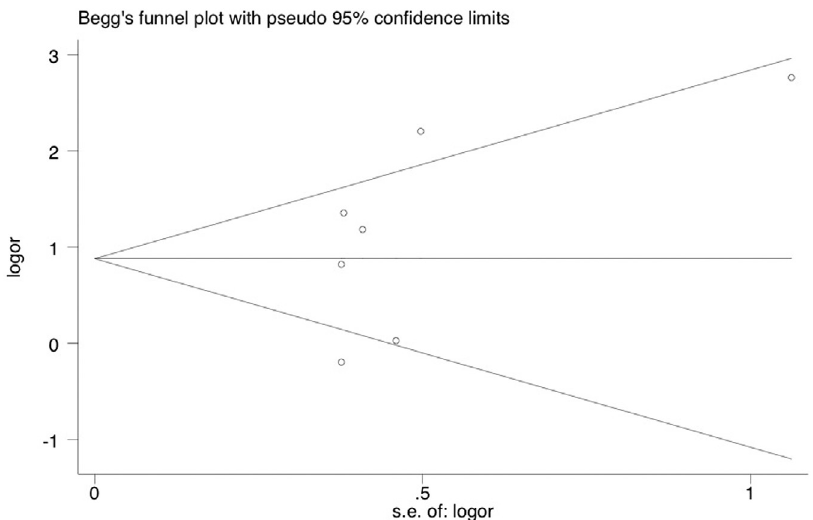
Figure 6- Begg’s funnel plot for publication bias in selection of studies on the TNF α -308 G/A polymorphism. The horizontal line represents the meta-analysis summary estimate, and the diagonal linespseudo-95%CI limits about the effect estimate. In the absence of publication bias, studies will be distributed symmetrically above and below the horizontal line. Asymmetry on the bottom of the graph indicates evidence of publication bias towards studies. logOR, natural logarithm of the OR; s.e. of logOR, standard error of the logOR